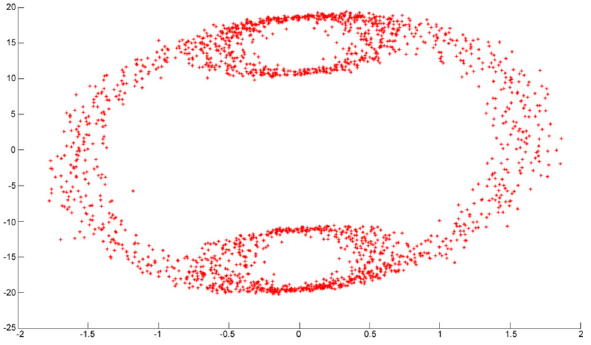
Figure 12. Chaotic trajectory for power system signal with harmonics